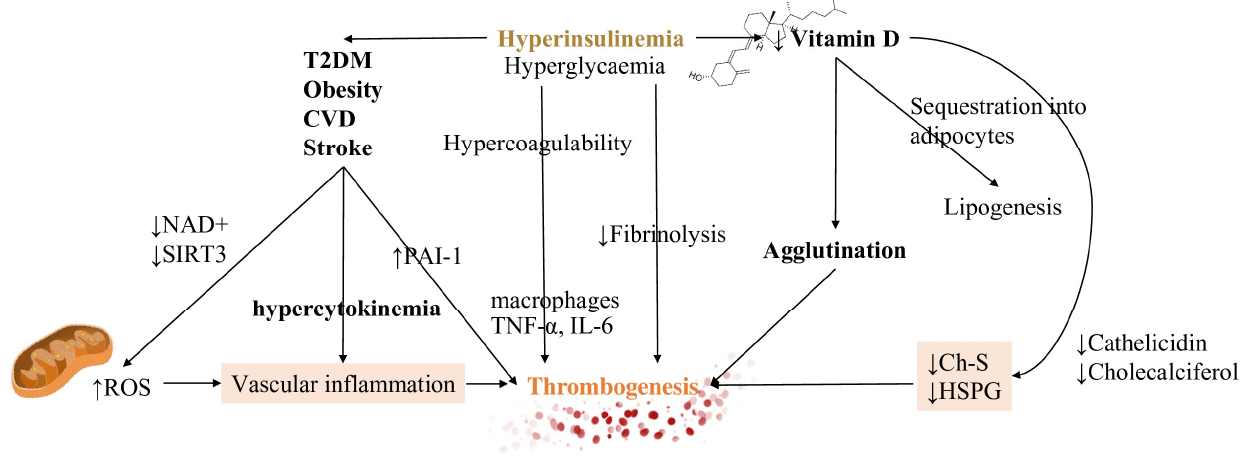
Figure 3. Hyperinsulinemia, CVD and vitamin D have a strong impact on homeostatic equilibrium. Both hyperinsulinemia (depicted in bold and colored font, in order to emphasize it) and hyperglycemia generate states of increased coagulation and decreased fibrinolysis. By driving the development of CVD, diabetes mellitus and obesity, they contribute to the inflammatory substrate of cytokines. They increase the ROS production due to the damage in decreasing both NAD+ and reduced glutathione (GSH). A reduction in vitamin D, due to sequestration into the adipocytes, leads to decreased levels of ChS and HSPG, regulators of RBCs deformation, increasing cells agglutination. These mechanisms are all responsible for thrombosis initiation. Vascular inflammation and decreasing levels of Ch-S and HSPG are represented with colored backgrounds being the main actors of thrombogenesis trigger. Also, thrombogenesis, the main effect, is outlined with a different color too. Abbreviations : Ch-S: cholesterol sulfate, HSPG: heparan sulfate proteoglycans, NAD+: nicotinamide adenine dinucleotide, PAI-1 plasminogen activator inhibitor type 1, ROS: reactive oxygen species, T2DM: type 2 diabetes mellitus, SIRT3: sirtuin 3, TNF- α : tumor necrosis factor- α , IL-6: interleukin